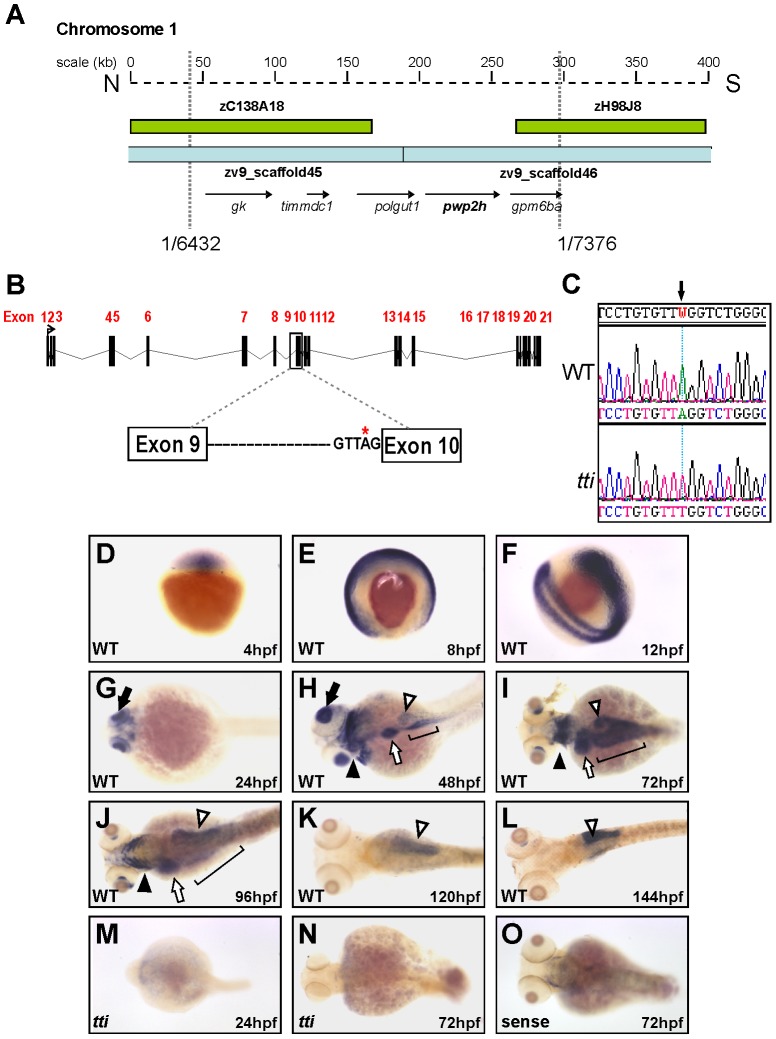
Positional cloning reveals that pwp2h is the mutated gene in ttis450.(A) Physical map of chromosome 1 in the region encompassing the ttis450 locus. Analysis of recombinants from 7376 meioses narrowed the genetic interval containing the mutation to a region flanked by 2 BACs (green boxes) and encompassed by 2 scaffolds zv945445 and zv945446 (blue bars) containing 5 genes (arrows). (B) Schematic representation of the pwp2h gene and the location of the sequence variation in intron 9. (C) The nucleotide sequence of pwp2h cDNA from ttis450 larvae contains an A→T transversion. Wholemount in situ hybridization (WISH) reveals the pwp2h mRNA expression pattern from 4–144 hpf in WT larvae (D–L). pwp2h expression is ubiquitous from 4–12 hpf (D–F), restricted to the retina at 24 hpf (G; black arrow) and encompasses the pharyngeal cartilages (black arrowhead), liver (white arrow), intestine (bracket) and pancreas (white arrowhead) at 48 hpf (H), 72 hpf (I) and 96 hpf (J). From 120–144 hpf pwp2h expression is restricted to the pancreas (K–L; white arrowhead). pwp2h expression is barely detectable at 24 hpf (M) and 72 hpf (N) in ttis450 larvae. Staining is absent in the sense control at 72 hpf (O) and at all other time points (data not shown).